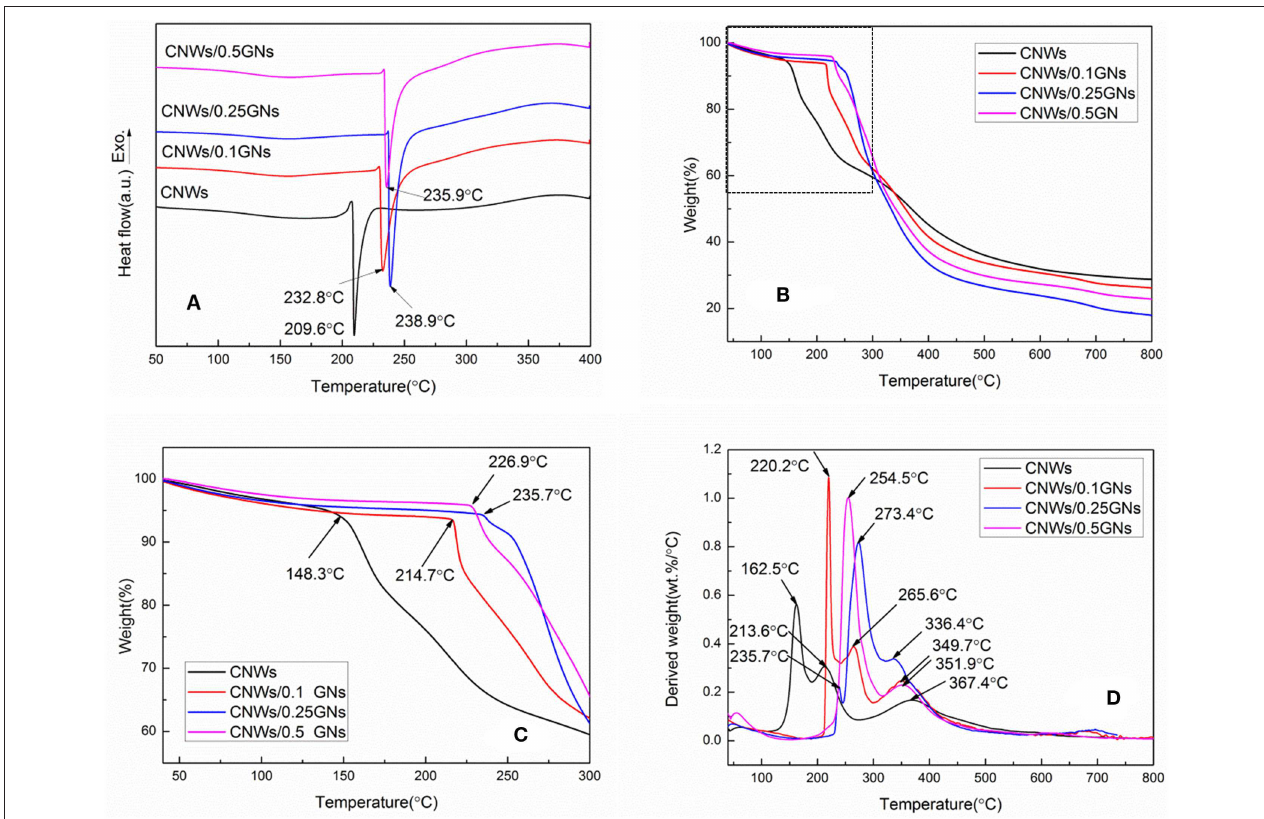
FIGURE 3 | Thermograms of CNW films and CNW/GN composite films: (A) DSC curves, (B) TGA curves, (C) enlarged TGA curve portion within the dash-line block in (B) , and (D) DTG curves.